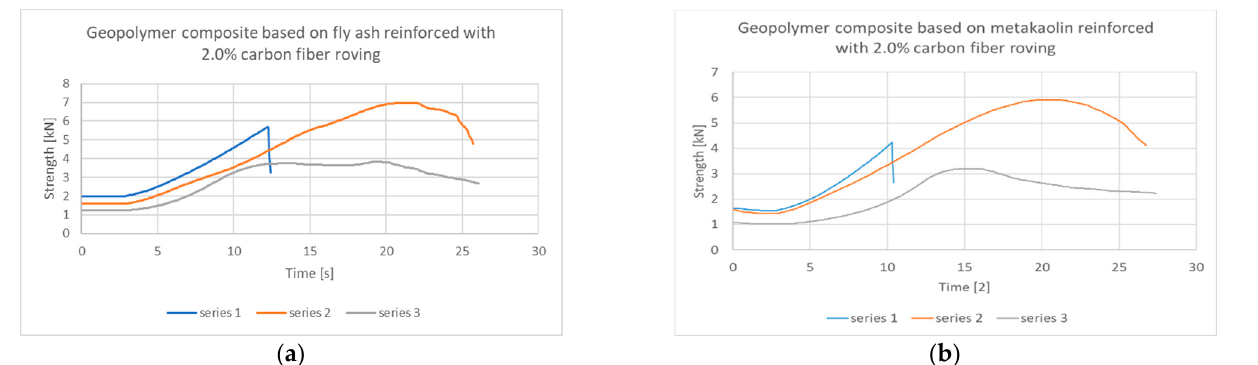
Figure 7. Strength–time composite behavior for a geopolymer matrix based on: ( a ) fly ash with 2.0% carbon fiber roving; ( b ) metakaolin with 2.0% carbon fiber roving.